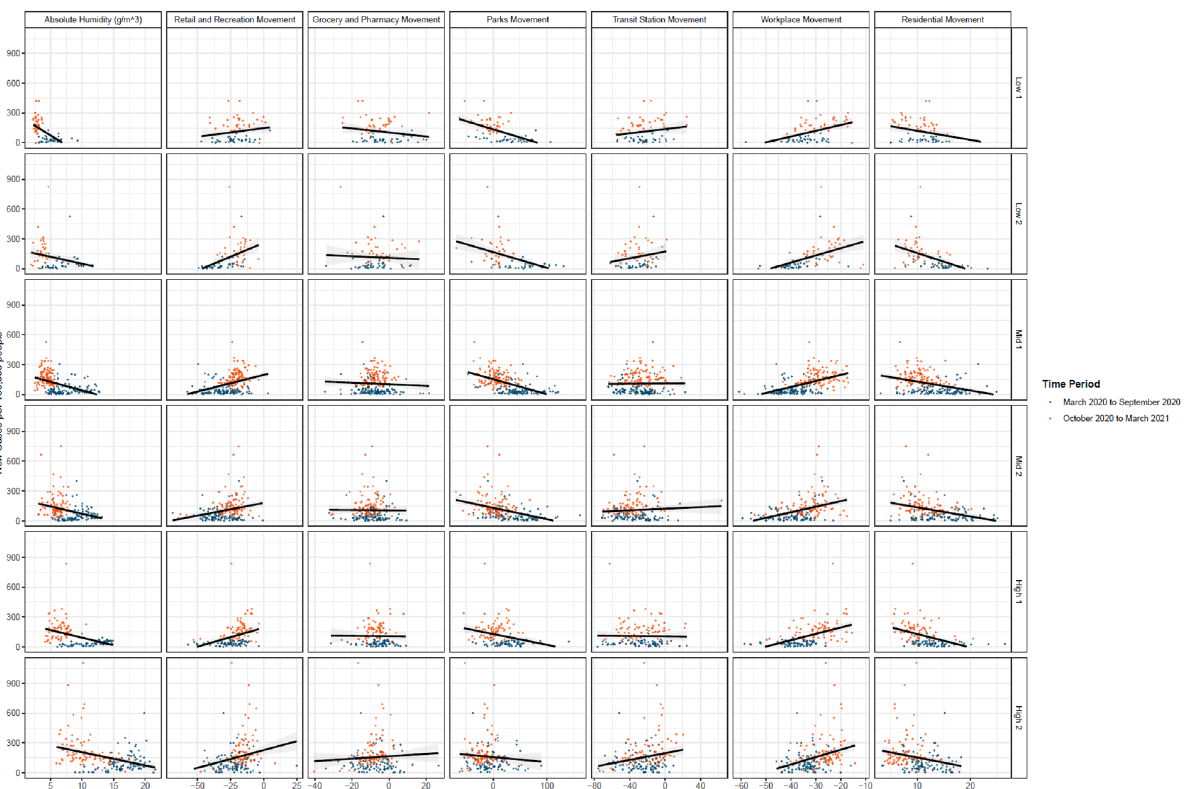
Figure 2. The average daily new cases per 100,000 people plotted against the average Google Mobility Measure of 497 counties for the entire study duration. The plots are organized by type of movement and cluster group. For each plot, we added a simple linear trend line with shaded standard